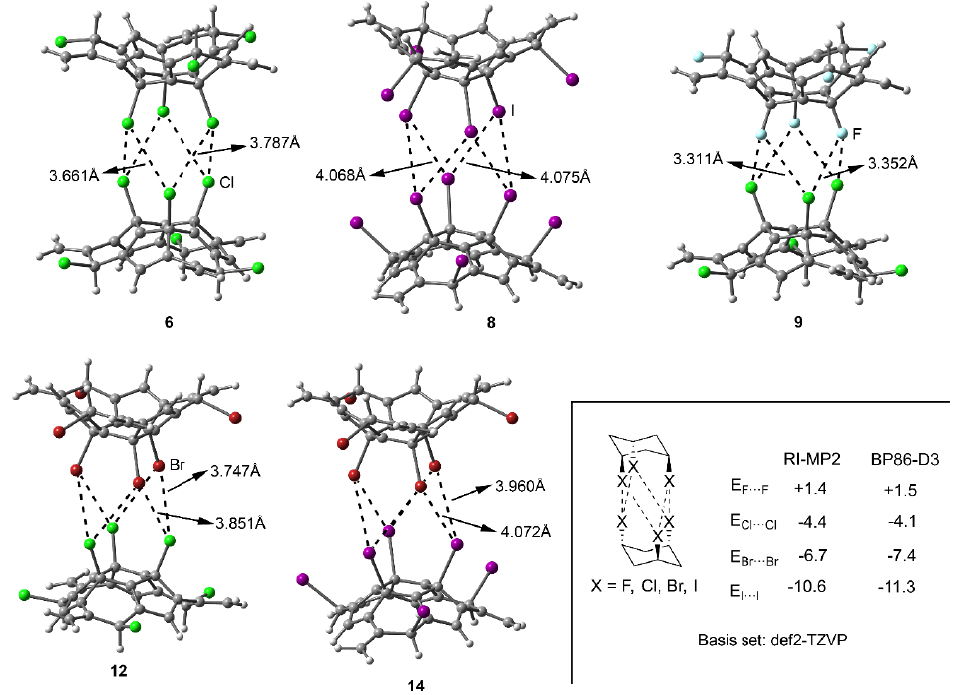
Figure 3. BP86-D3/def2-TZVP optimized geometries of some representative complexes. The theoretical models and basis set superposition error (BSSE) interaction energies using both RI-MP2 and BP86-D3 methods are also given.